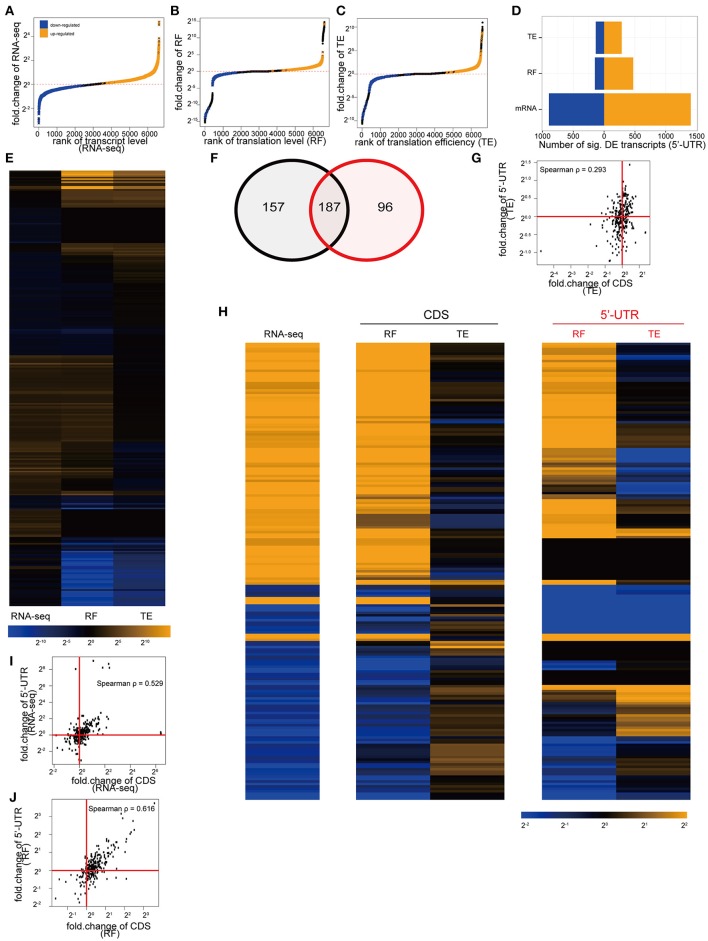
Depolarization of cultures also alters ribosomal occupancy of the 5′UTR of specific transcripts. (A) Cumulative distribution showing the alteration of 5′UTR transcript levels by KCl stimulation in culture. One thousand four hundred and five transcripts were significantly upregulated (orange), and 895 downregulated (blue) (all unadjusted p < 0.05, permuted t-statistic). (B) Cumulative distribution showing alteration of 5′UTR translation levels by KCl stimulation. Four hundred and seventy one transcripts were upregulated, and 149 downregulated. (C) Cumulative distribution showing alteration of TE (5′UTR) by KCl stimulation. Two hundred and eighty five transcripts were upregulated, 135 downregulated. (D) Bar plot of summary of number of transcripts being up/downregulated. (E) Heatmap of log2 fold-changes for highly altered transcripts (showing those genes with fold-change in top or bottom 5% for 5′UTR RNAseq, RF or TE, n = 283). (F) Transcripts showing a significant change in TE in their CDS (black circle) are more likely to also show a significant change in the TE of their 5′UTR (red circle) (p < 2.2e-16. Chi-square statistic = 2333, two-sided). (G) Scatterplot of TE fold-change in 5′UTR and CDS shows weak correlation. (H) Heatmaps for the fold-changes of the 187 overlapping transcripts from (F). There is no consistent relationship in TE fold-change between CDS and 5′UTR across all transcripts. (I) Scatterplot of RNAseq fold-change in 5′UTR and CDS shows high correlation. (J) Scatterplot of RF fold-change in 5′UTR and CDS shows high correlation.